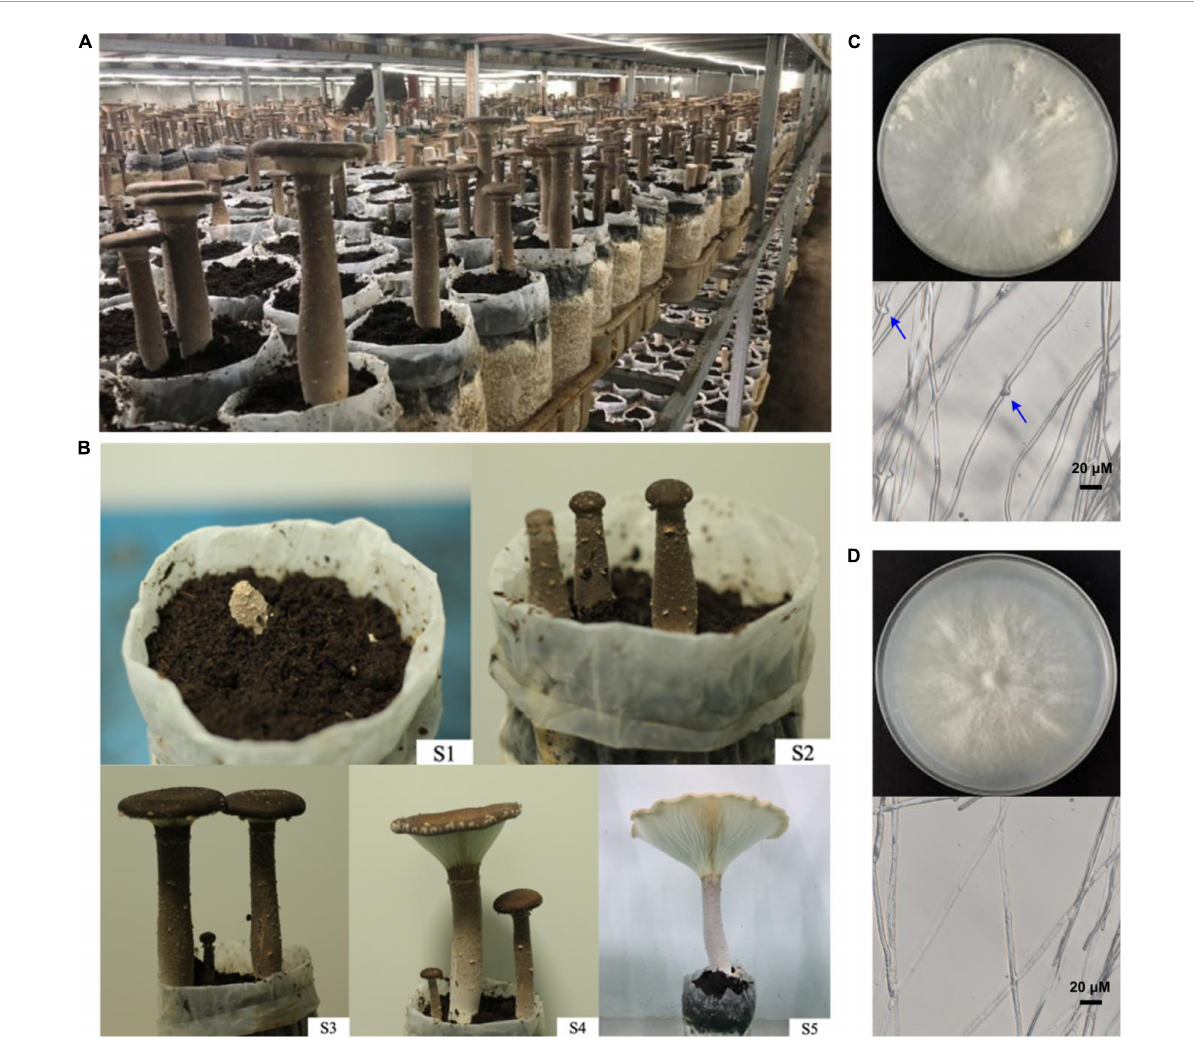
FIGURE1 Life cycle of P. giganteus . (A) Industrially cultivated P. giganteus . (B) Fruiting body of P. giganteus at different stage of life cycle. (C) Dikaryotic mycelia of the P. giganteus Shen Xun 1 Hao strain. Clamp connections were indicated by arrows. (D) Monokaryotic mycelia of the P. giganteus zhudugu2